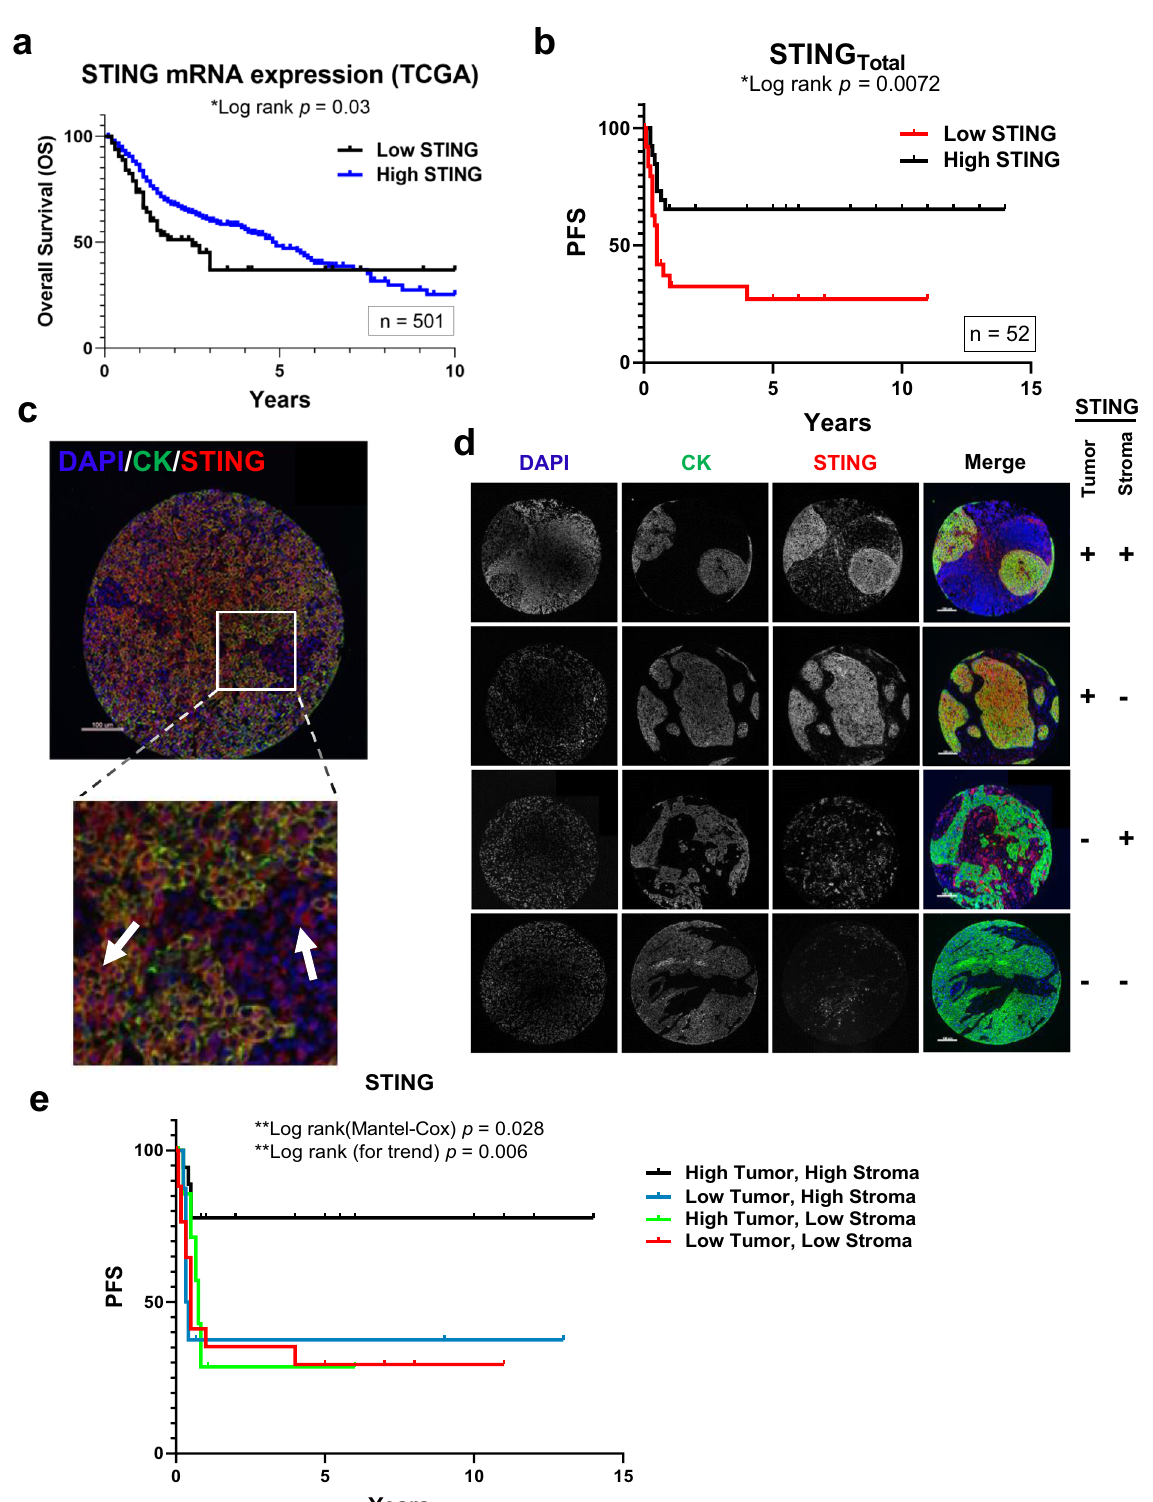
Fig. 5 STING expression and outcomes in HNSCC. a Kaplan – Meier curves of HNSCC TCGA cohort strati fi ed by STING mRNA expression (low vs high). b Kaplan – Meier curves of patients strati fi ed by total STING expression (low vs high). c Representative images of TMA spot from b stained for DAPI, cytokeratin (tumor mask), and STING. Arrows indicated STING staining in both compartments (tumor and stroma). d Representative images of TMA spots illustrating grouping of TMA specimens into four groups based upon compartmental STING expression. Each patient specimen was stained once due to lack of material, with images representative of their respective groups: b (from entire patient cohort) or d (groups de fi ned in e ). e Kaplan – Meier curves of patients strati fi ed by four groups identi fi ed in d . All statistical analysis was performed by log-rank testing with P -values as indicated in graphs. Scale bars are 100 μ m in c and d